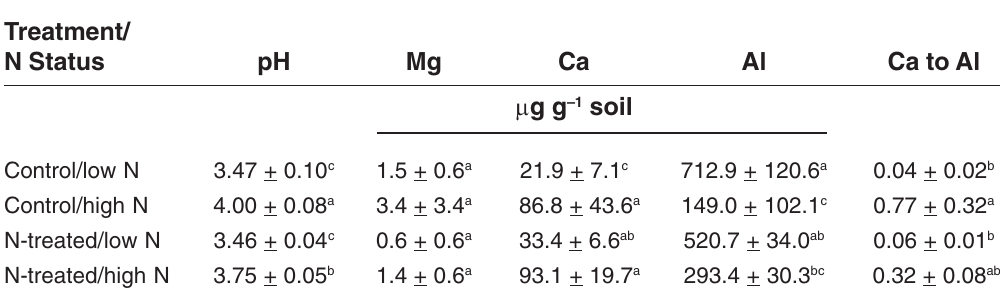
Means (+1 SE) for Extractable Mg, Ca, and Al; pH; and Ca to Al Ratios for Low N Processing and High N Processing Plots Within Control and N-Treated Watersheds of Fernow Experimental Forest, West Virginia*